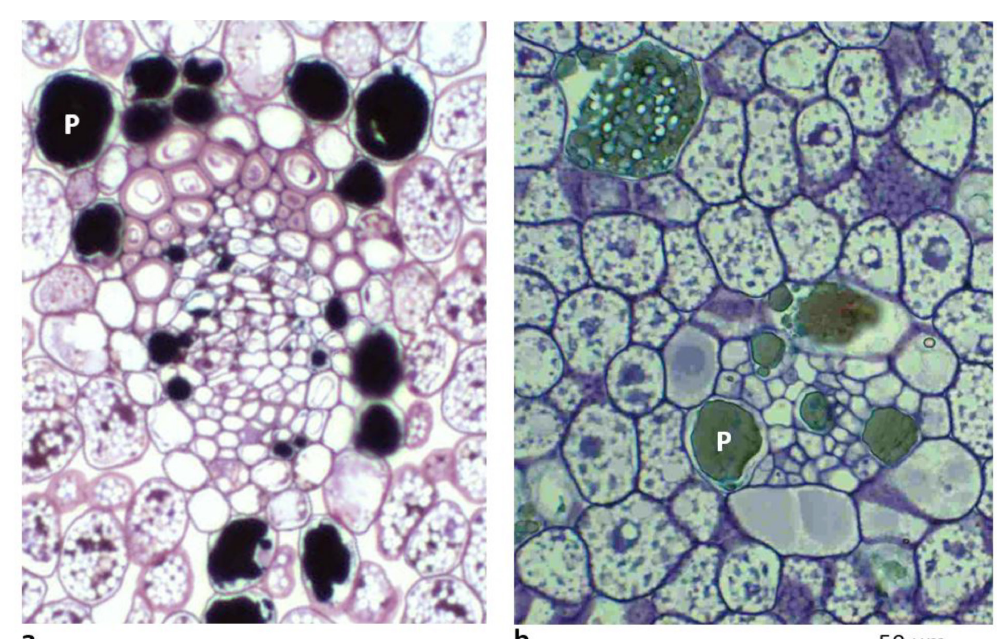
Fig. 8: Vascular bundles in tstorage cotelydons of T. grandiflorum (a) and T. cacao (b) P: polyphenol cell Semi-thin sections, stained with Toluidine Blue